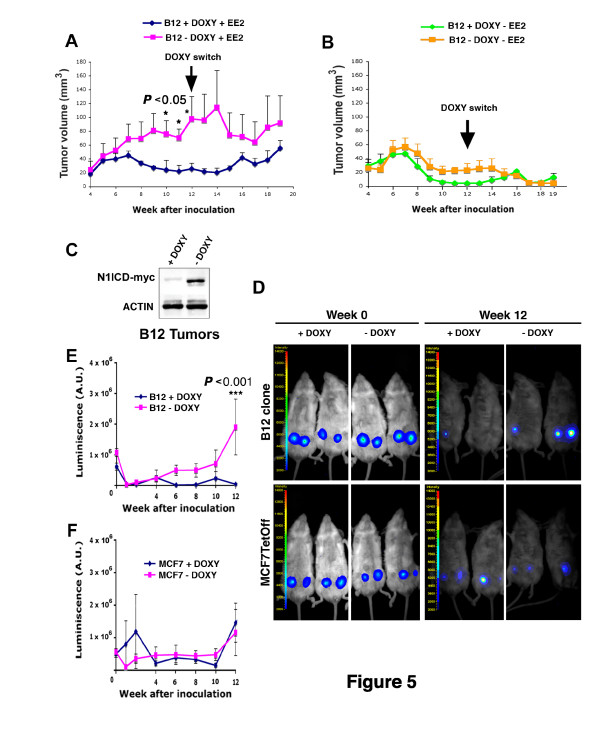
N1ICD induction promotes a tumorigenic behavior. (A) Growth of xenografts derived from MCF-7 B12 clone with induced N1ICD (-Doxy) or without N1ICD (+Doxy) expression. Mice also had 17α-ethynyl estradiol (+EE2) in the drinking water. The arrow indicates the 12th week when DOXY treatment was switched between both groups of mice. (B) Growth of N1ICD-induced B12 cells in the absence of estrogen (+EE2) administration. The arrow indicates the week 12th when DOXY treatment was switched. Data are mean ± SEM of n = 8 (four mice and two tumors per mice; *P <0.05 determined by two-way ANOVA with Bonferroni post-test). (C) Western blot showing expression of myc-tagged N1ICD in B12 tumors at 12th week of cell inoculation. (D) MCF-7 Tet-Off or the MCF-7 B12 clone engineered to express luciferase injected in the mammary gland of BALBc/SCID mice were monitored by bioluminescence emission at the time of cell inoculation and after 12 weeks as indicated. Selected images of two independents experiments, four animals per group. (E) Growth dynamics measured by luminescence of MCF-7 B12 clone with (-DOXY) or without (+DOXY) N1ICD expression. (F) Growth of control MCF-7 clones in the same conditions. Data are mean ± SEM of n = 8 (four mice and two tumors per mice; ***P <0.001 determined by two-way ANOVA with Bonferroni post-test), representative of two independents experiments. DOXY, doxyxycline; MCF-7, Michigan Cancer Foundation-7 breast cancer cell line; N1ICD, Notch one intracellular domain